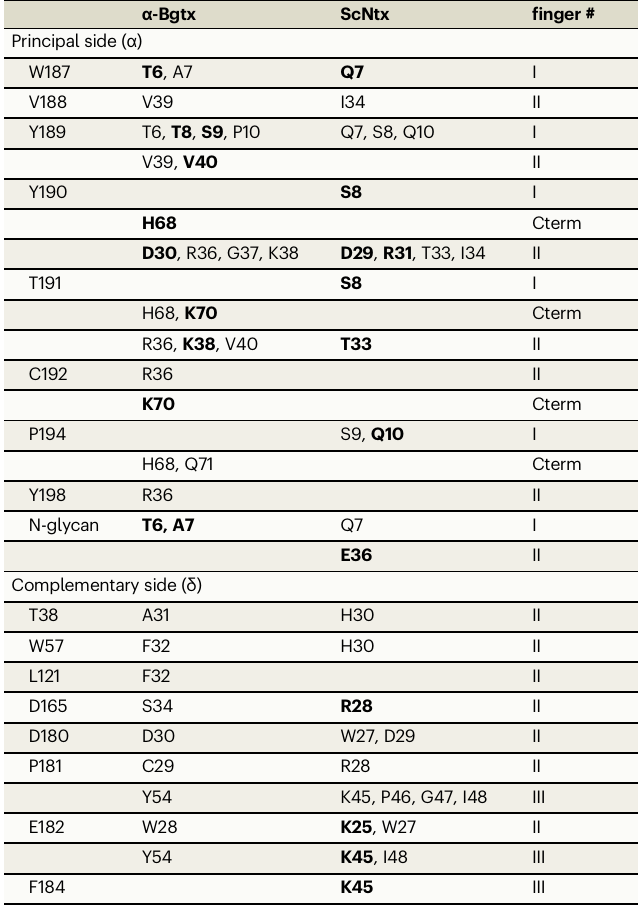
Table 1 | Contacts between ScNtx/ α -Bgtx and the α δ - δ inter- face of the Torpedo